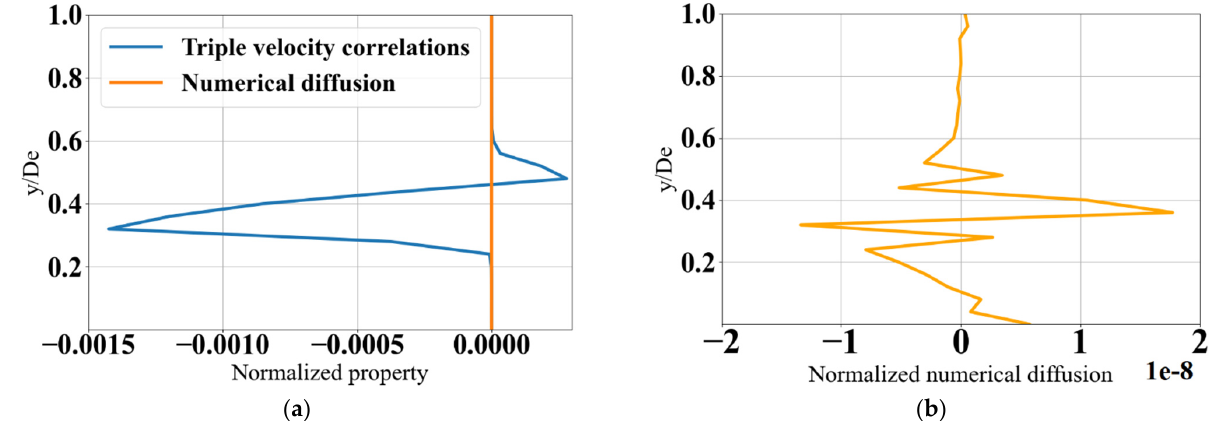
Figure 7. ( a ) Comparison of normalized triple velocity correlations with normalized numerical dif- fusion, ( b ) Normalized numerical diffusion, at x/De = 3.2 for LEShot .